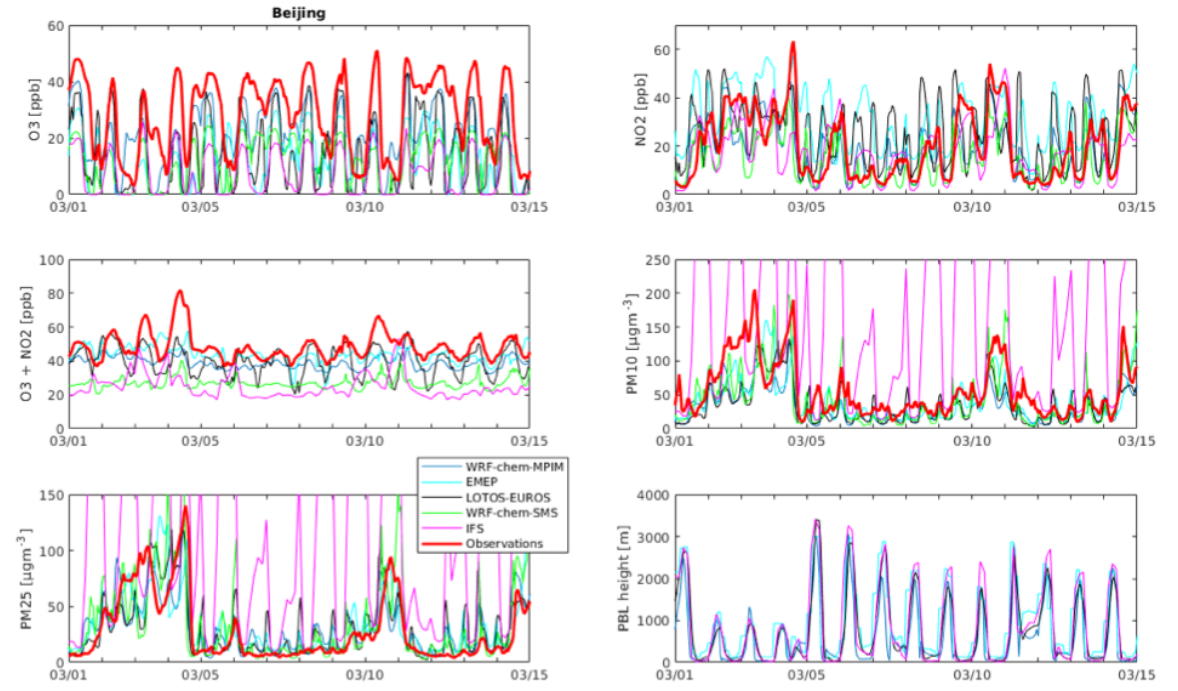
Figure 9. Forecast of the chemical concentrations of ozone, NO 2 , PM 2 . 5 , and PM 10 at Beijing between 1 and 15 March 2017 by the different models involved in the intercomparison conducted in the present study. The calculated values of O x = O 3 + NO 2 as well as the height of the planetary boundary layer (PBL) are also shown. The mean values from the measurements made at the different monitoring stations of Beijing are shown by the thick red